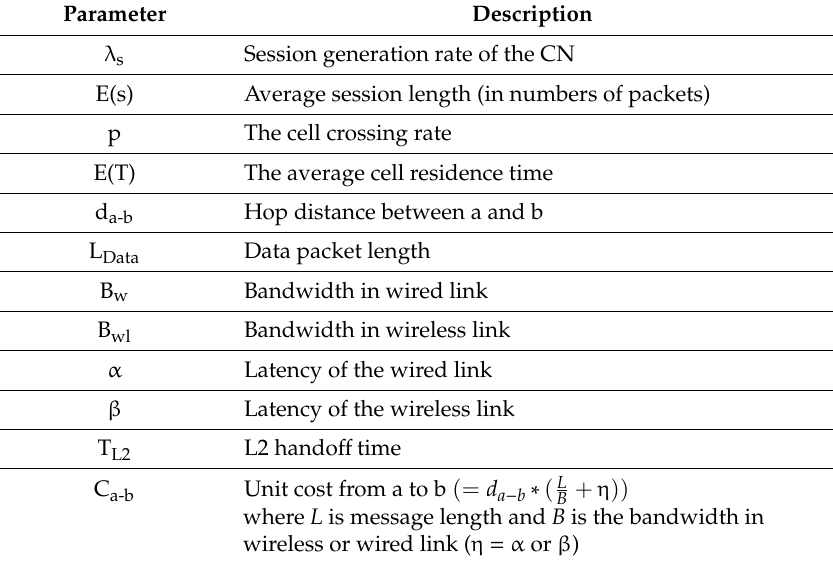
Table 2. Parameters for total cost analytical